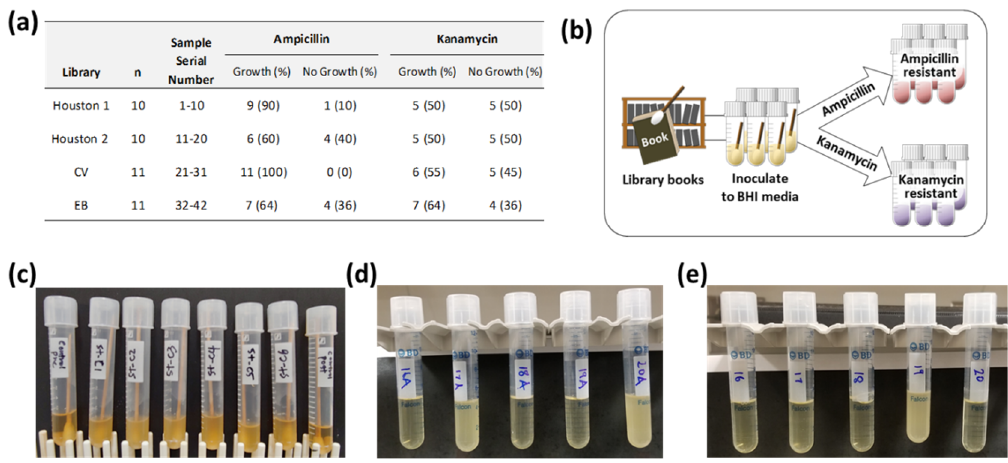
Figure 1. ( a ) summary number of sample origin location, numbers, and sample growth in each antibiotic-containing medium. ( b ) Procedure for antibiotic-resistant bacteria selection. ( c ) Example of culture of collected samples in normal brain–heart infusion (BHI) medium. Two negative controls show no bacteria growth in the first and last position. ( d ) Example of culture BHI growth of bacteria in ampicillin Luria broth (LB) medium. ( e ) Example of culture BHI growth of bacteria in kanamycin LB medium.